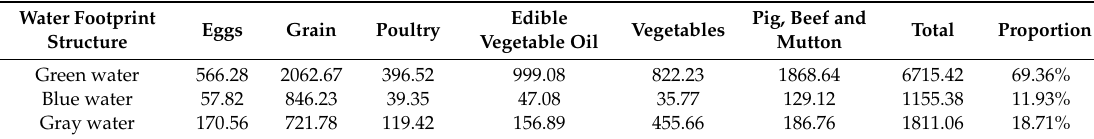
Table 2. Water footprint structure of the food consumed (billion m 3 ).